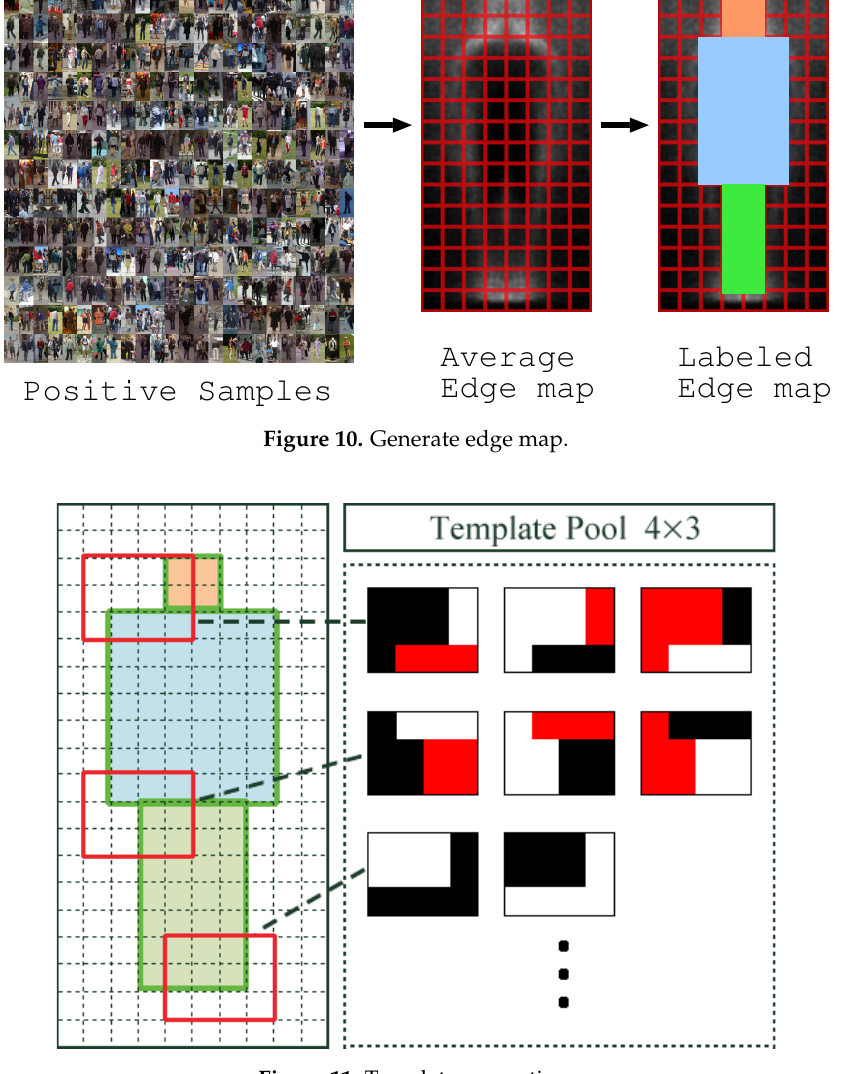
Figure 11. Template